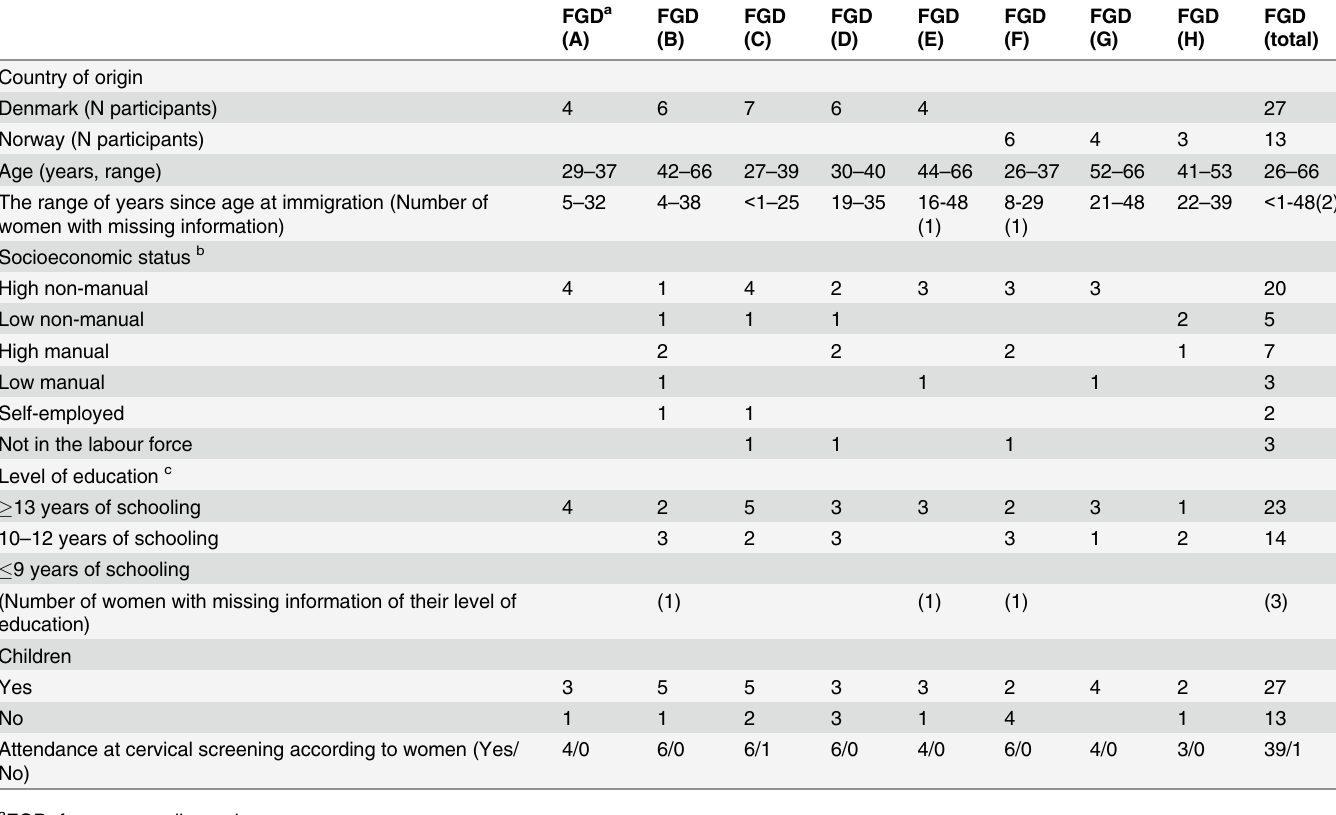
Table 1. Characteristics of the